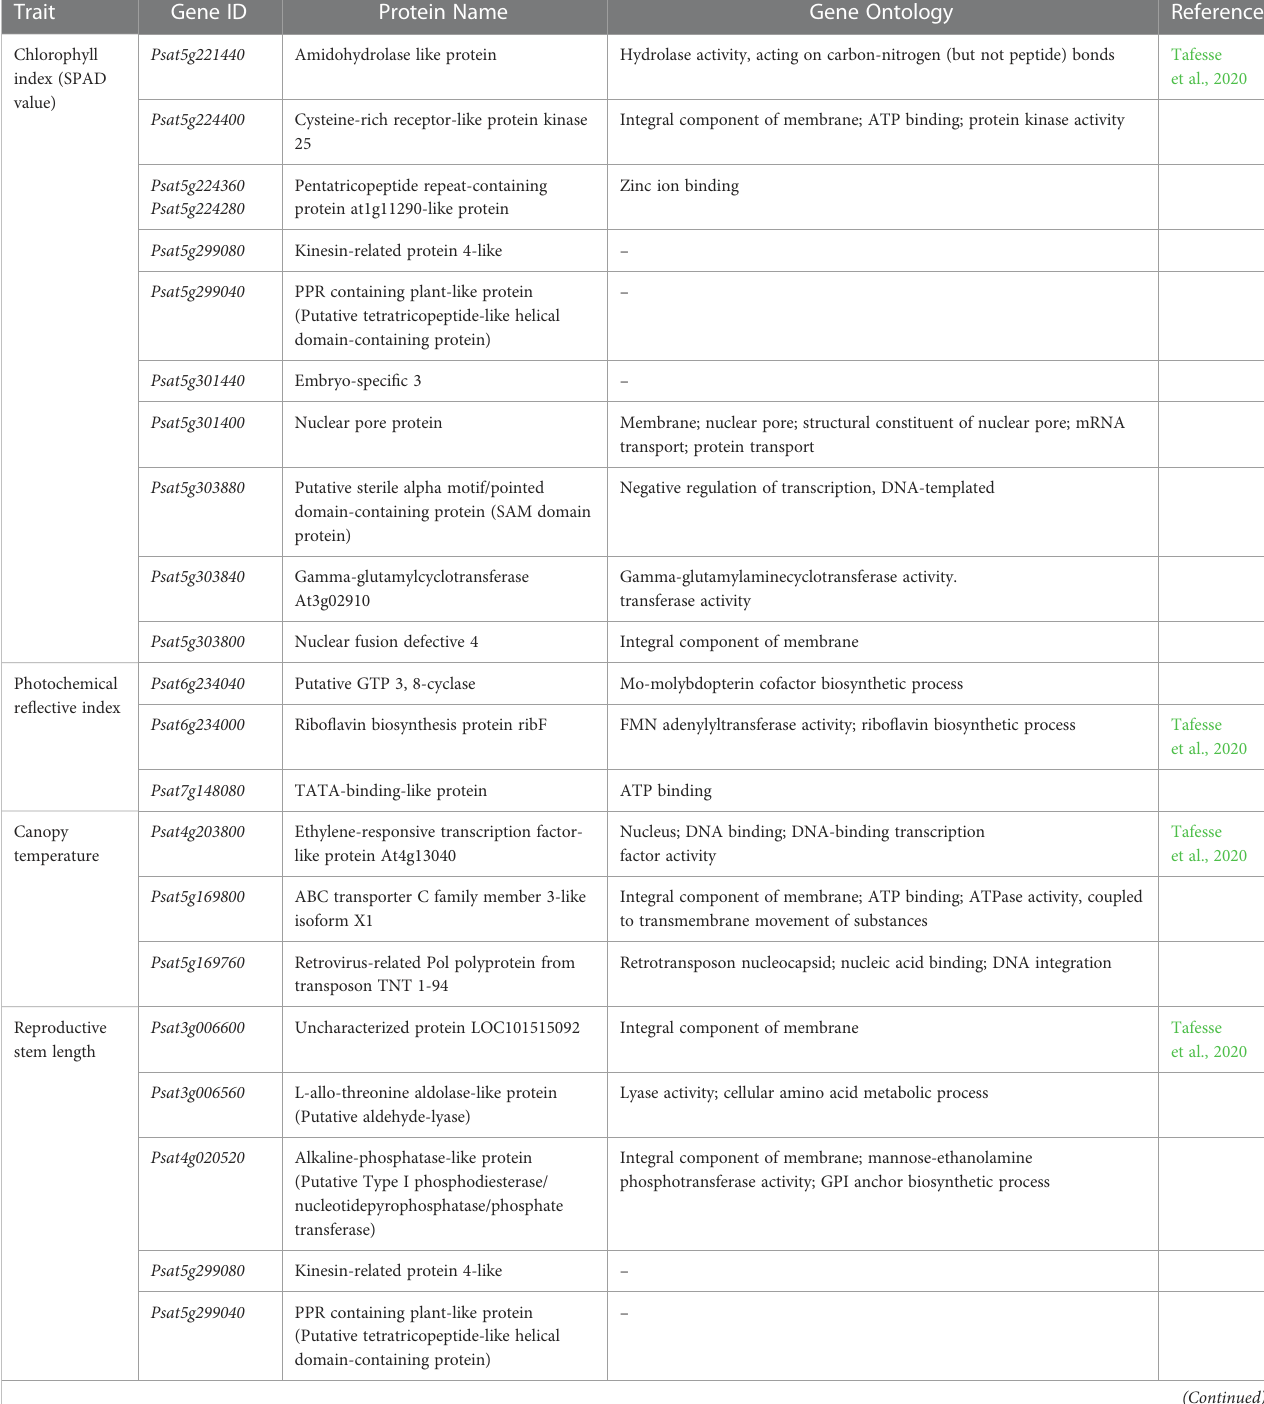
TABLE 4 The candidate genes identi fi ed in pea under the heat stress conditions. Trait Gene ID Protein Name Gene Ontology